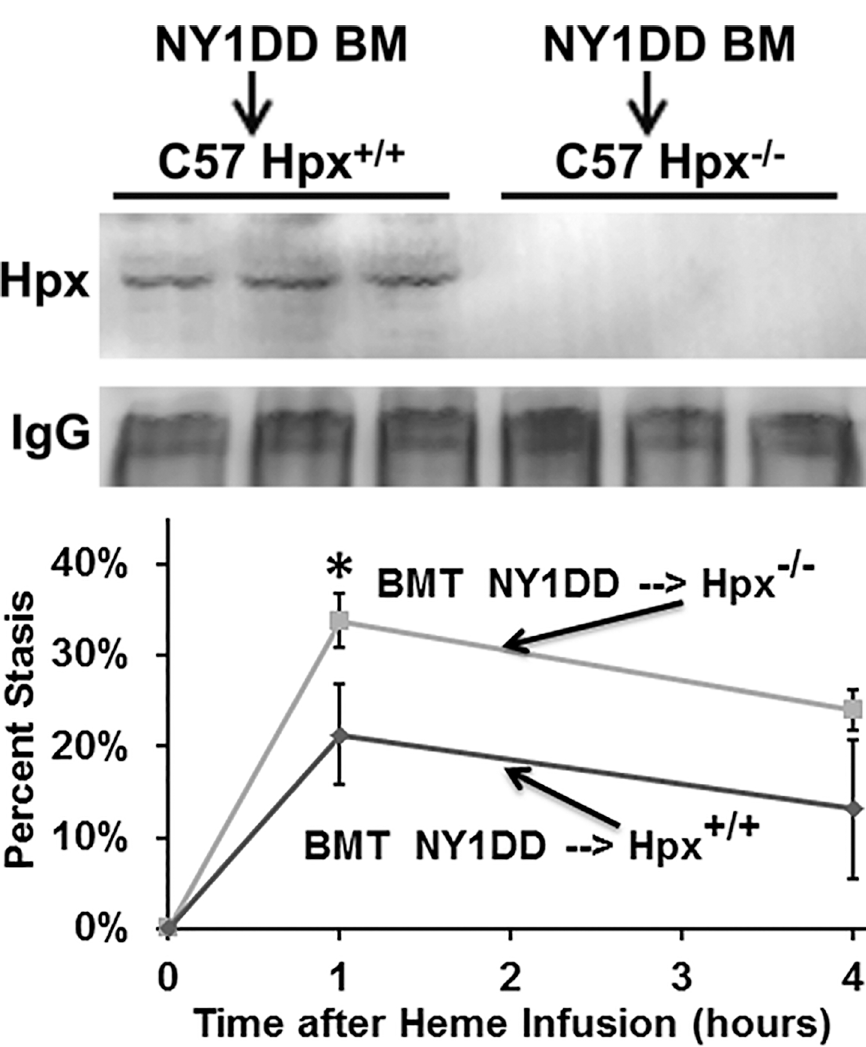
Figure 2. Hpx -/- sickle mice develop more stasis than Hpx +/+ sickle mice following heme infusion. NY1DD bone marrow (BM) was transplanted into C57BL/6 Hpx +/+ and C57BL/6 Hpx -/- mice (n = 3). Twelve weeks after BM transplant (BMT), plasma Hpx levels were examined on western blot (A) and microvascular stasis was measured in a DSFC at 1 h and 4 h after infusion of 3.2 μ mols/kg of heme (B). Percentage of stasis (mean ± SD) was calculated at 1 h and 4 h after heme infusion. * P < 0.025 NY1DD Hpx +/+ versus NY1DD Hpx -/-